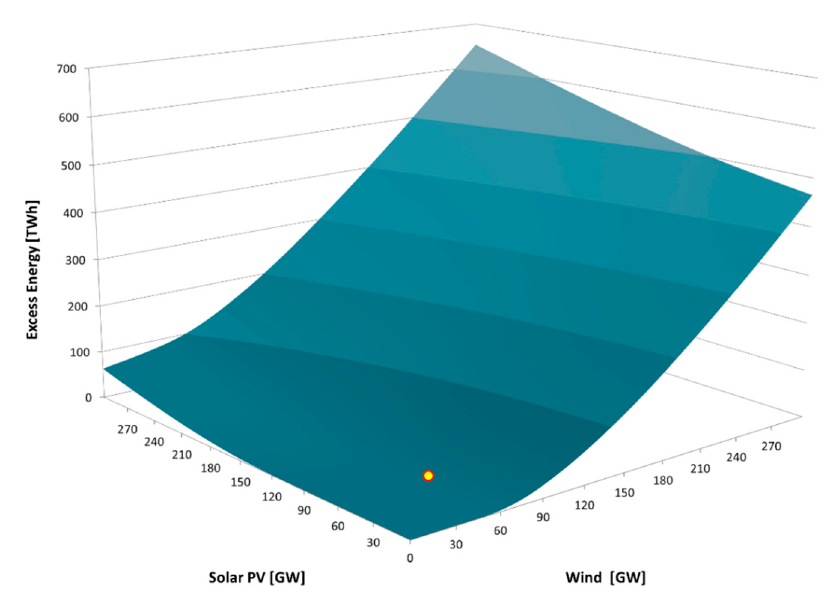
Figure 7. EE surface plot Case A including the 2017 capacities from wind and solar PV (point marking).